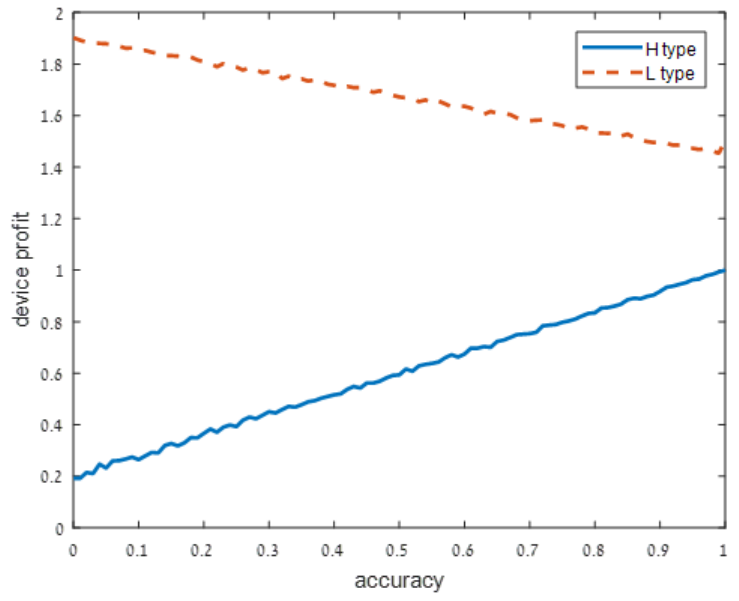
Figure 4. Low noise: (cid:101) =